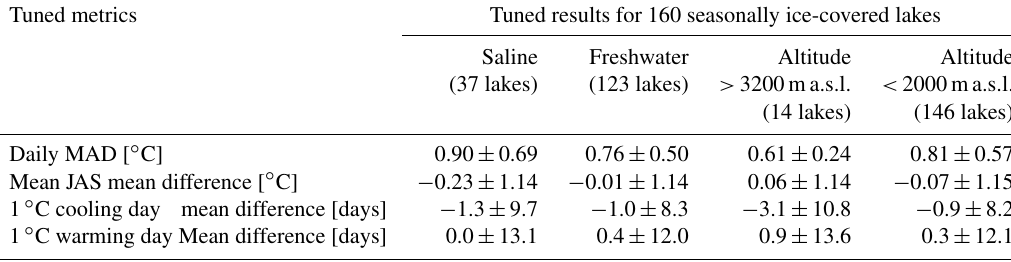
Table 7. Comparison of tuned model results for saline, freshwater, high and low altitude seasonally ice-covered lakes, with the spread of differences across lakes, 2 σ . The metrics are explained in Table 4. Units are given in square brackets. Tuned metrics Tuned results for 160 seasonally ice-covered lakes Saline Freshwater Altitude